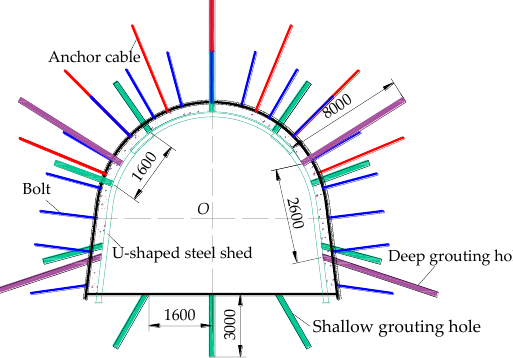
Figure 8. The GR-CDSH scheme (Unit: mm).